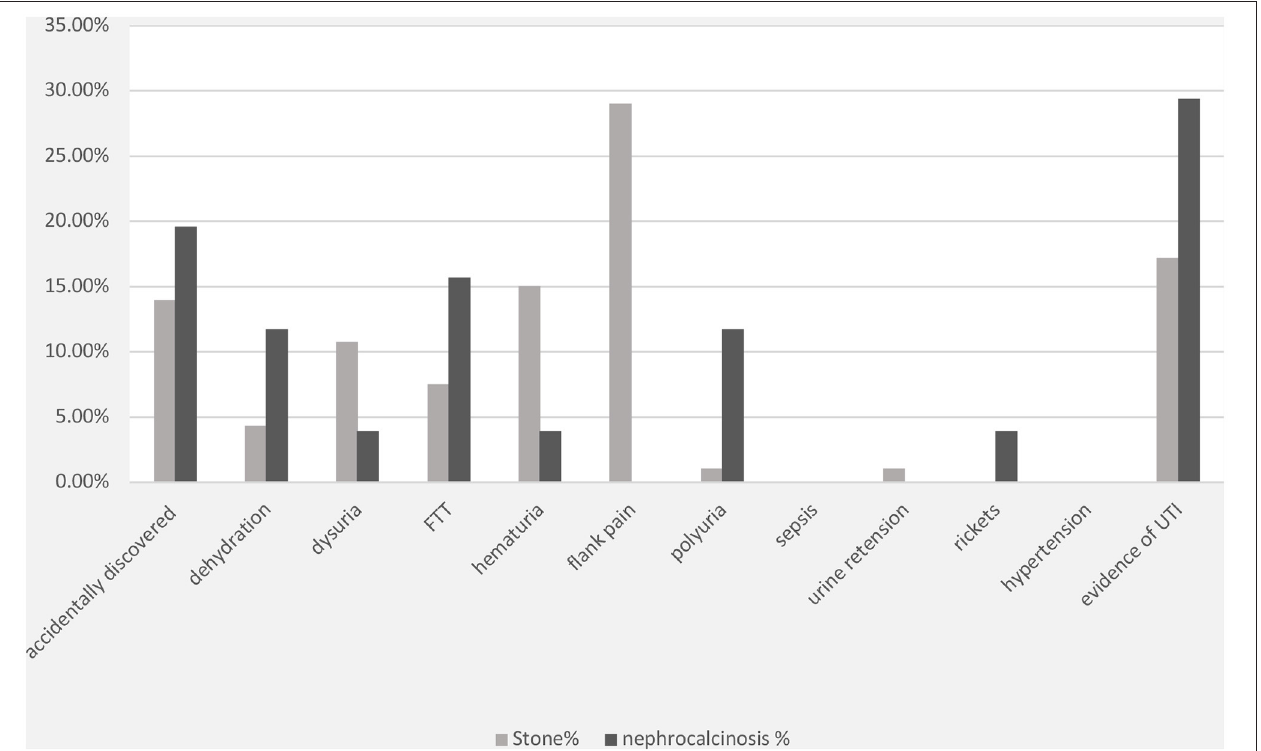
FIGURE 1 | Clinical presentations of patients with nephrolithiasis/urolithiasis (renal stone) and nephrocalcinosis. FTT, failure to thrive; UTI, urinary tract infection; FHHNC, familial hypomagnesemia hypercalciuria nephrocalcinosis.